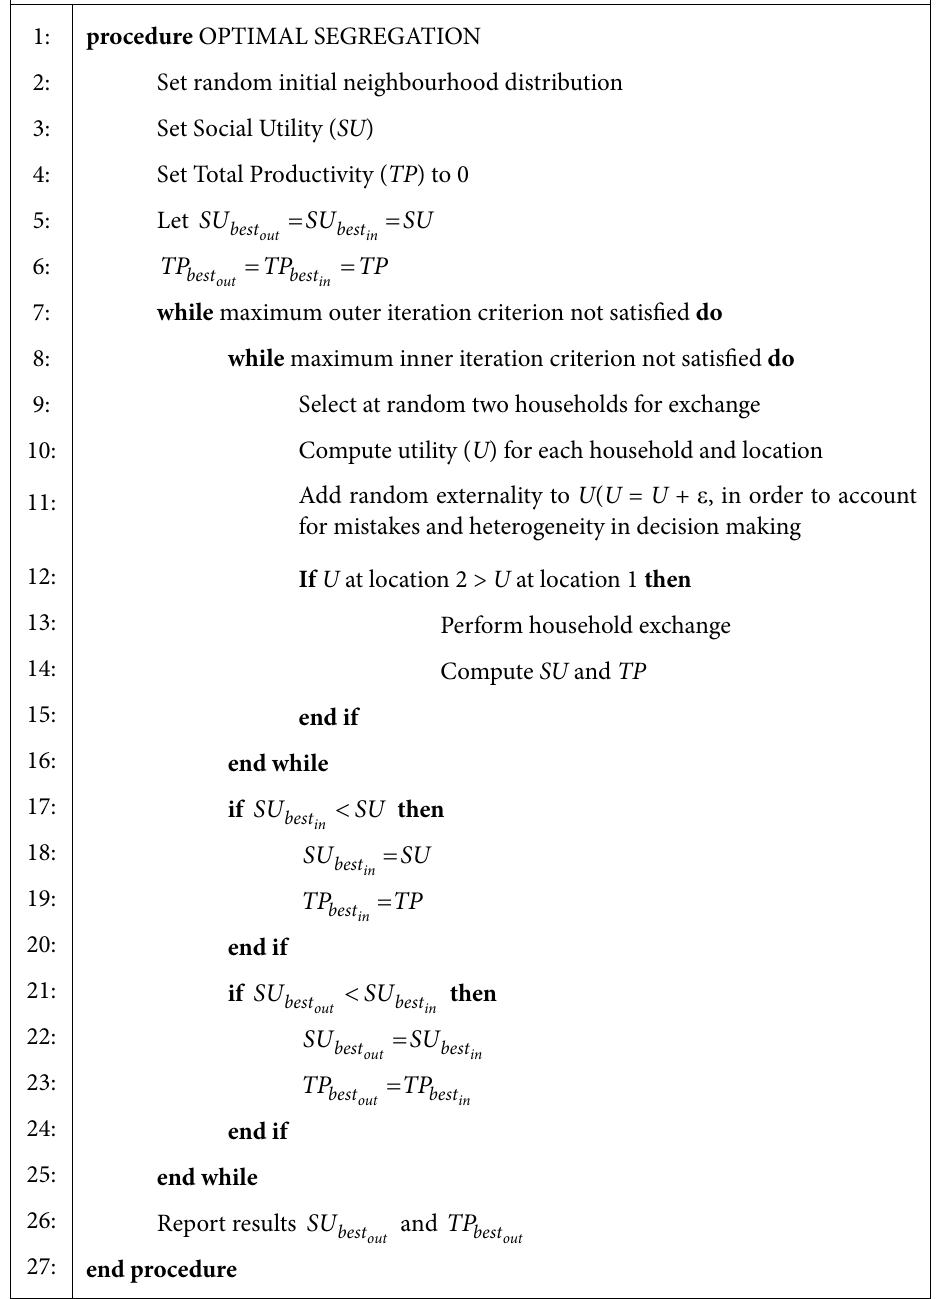
Algorithm 2 Optimal Segregation